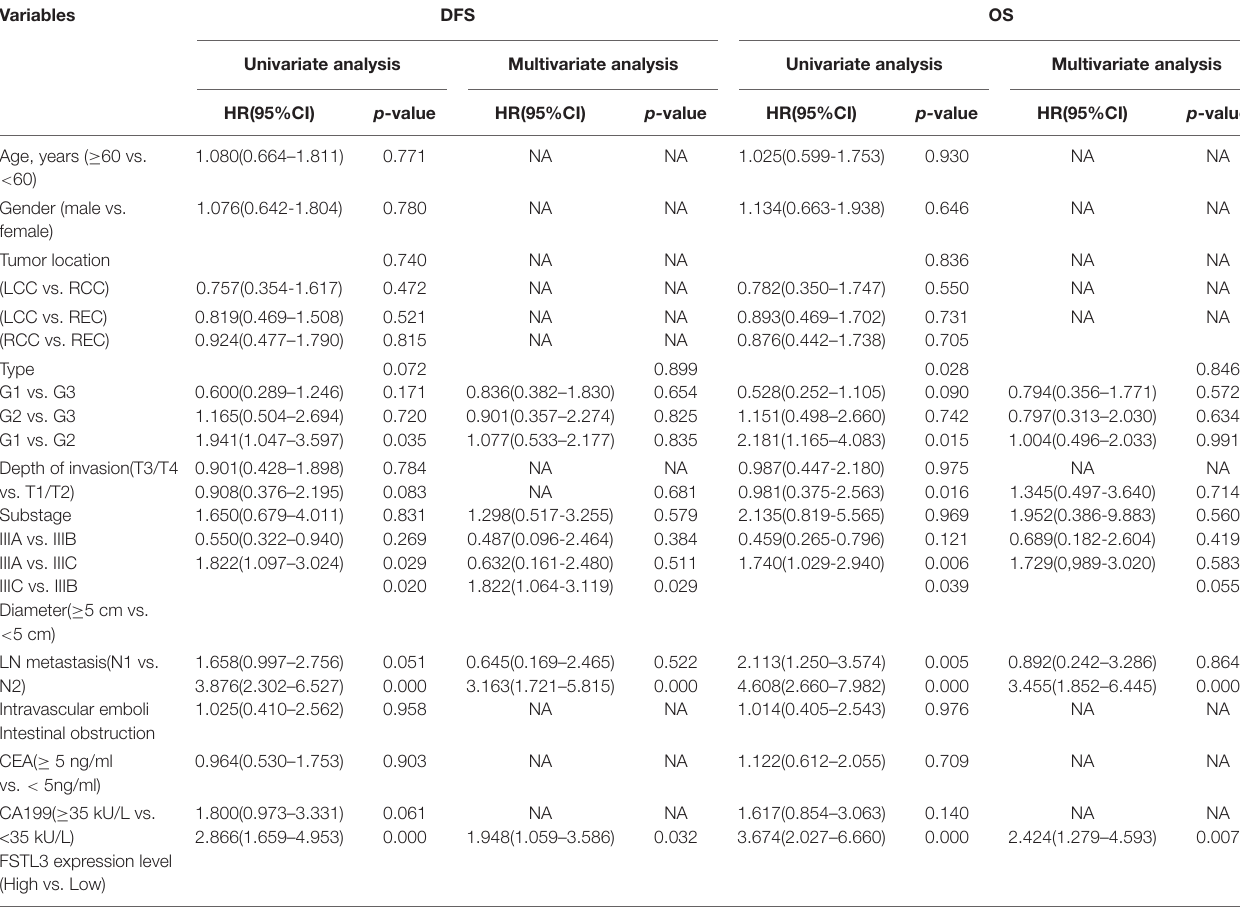
TABLE 2 | Univariate and multivariate analysis of 130 CRC patients for DFS and OS.